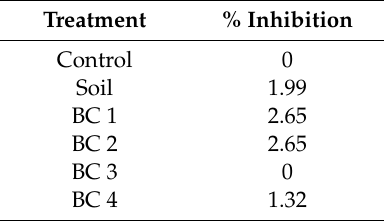
Table 6. Results of the growth inhibition tests with Paramecium caudatum . n = 5.